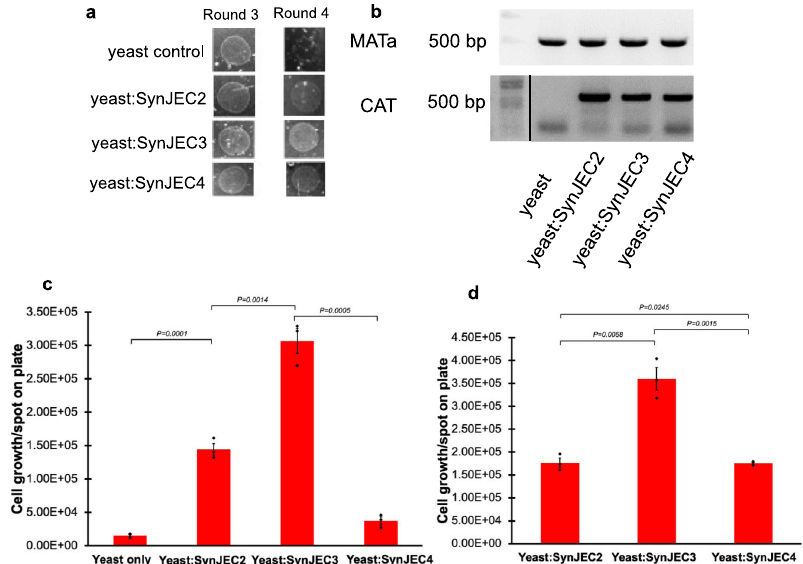
Fig. 3 Rescue of respiration de fi cient phenotype by yeast- SynJEC chimeras expressing an ATP/ADP translocase and SNARE-like proteins. a Growth of S. cerevisiae cox2-60 – SynJEC2 — 4 chimeras on medium containing glycerol as the sole carbon source. The experiment was repeated three times independently with similar results. b Total DNA of yeast- SynJEC chimeras contains yeast MATa and SynJEC CAT genes. The experiment was repeated three times independently with similar results. c , d Growth trends of S. cerevisiae cox2-60 (yeast only strain), S. cerevisiae cox2-60- SynJEC2 (yeast-SynJEC2), S. cerevisiae cox2-60- SynJEC3 (yeast-SynJEC3) and S. cerevisiae cox2-60- SynJEC4 (yeast-SynJEC4) chimeras on Selection Medium III. Cells (3.00 × 10 3 ) were spotted on Selection Medium III the fi nal number of cells/spot on plate were determined after 72 h of growth ( N = 3 technical replicates; data are presented as mean values + / − SEM). P -values were calculated by two-tailed t -test comparing the two means. Source data are provided as a Source Data fi